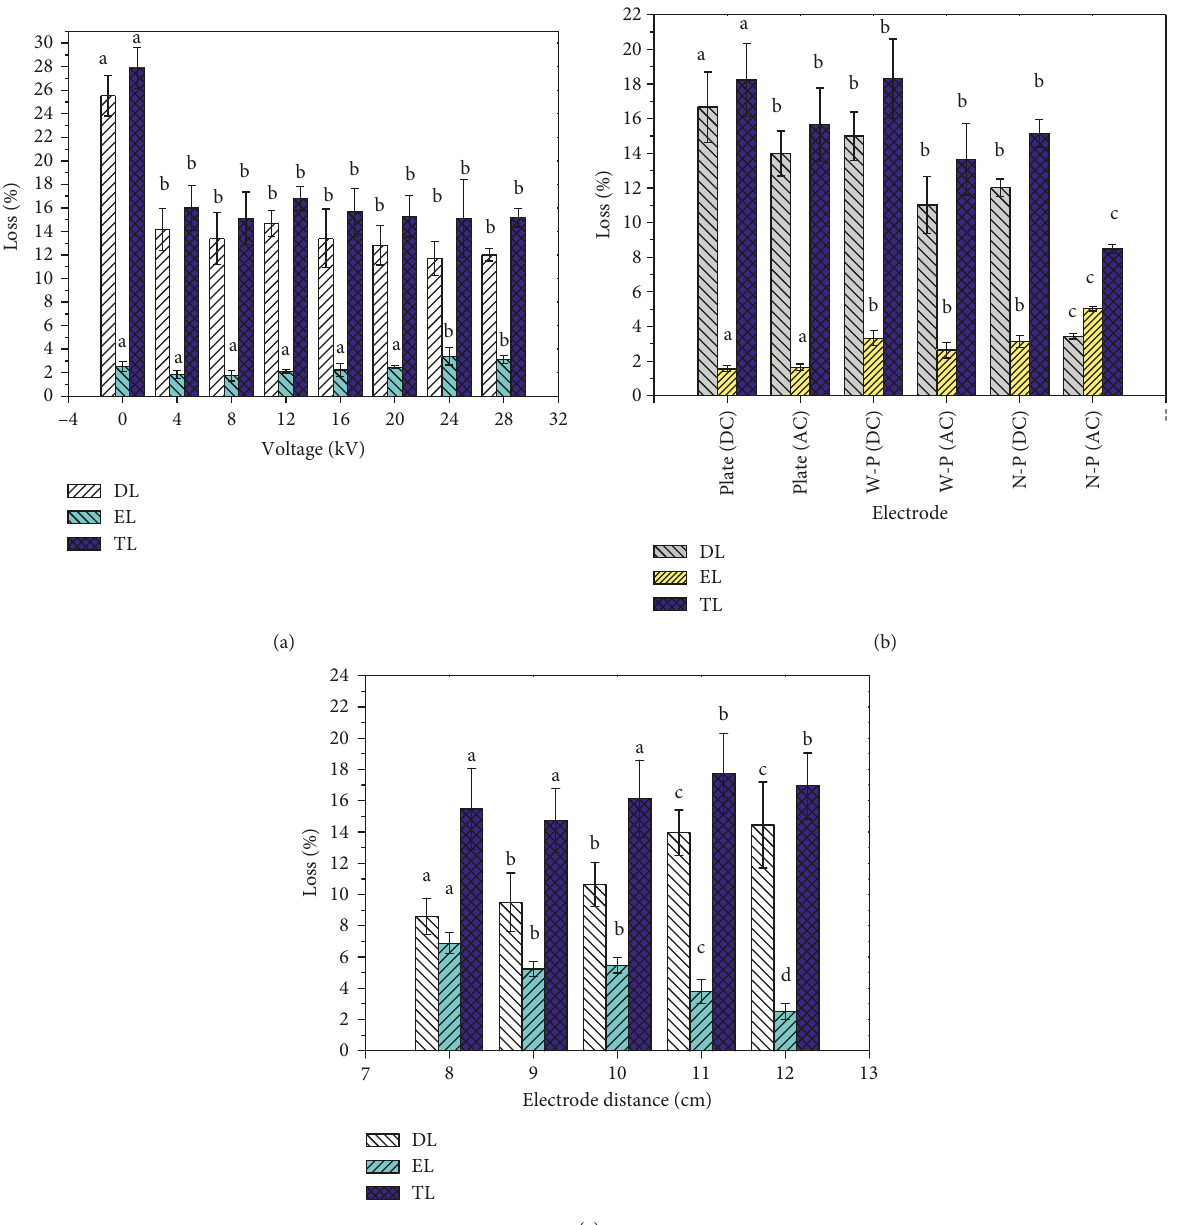
Figure 4: (a) The evaporation loss, thawing loss, and drip loss of tofu under different voltages. The frozen tofu was thawed at 20 ° C with a fixed discharge gap of 100mm under DC electric field. The thawing voltage was 0kV (the control samples), 4kV, 8 kV, 12kV, 16kV, 20kV, 24kV, or 28kV, respectively. For each treatment, means with different lower case letters are significantly different ( p evaporation loss, thawing loss, and drip loss of tofu under different electrodes. Plate (DC): the plate-to-plate electrodes under DC electric field, plate (AC): the plate-to-plate electrodes under AC electric field, W-P (DC): the wires-to-plate electrodes under DC electric field, W-P (AC): the wires-to-plate electrodes under AC electric field, N-P (DC): the needles-to-plate electrodes under DC electric field, and N-P (AC): the needles-to-plate electrodes under AC electric field. The corresponding discharge gap between the high-voltage electrodes and the grounded electrode was 100mm. The corresponding voltage was 28kV. For each treatment, means with different lower case letters are significantly different ( p 0 . 05). (c) The evaporation loss, thawing loss, and drip loss of tofu under different electrode distances. The discharge gap was 8 cm, 9cm, 10cm, 11cm, and 12cm with multiple needles-to-plate electrode for AC electric field, respectively. The corresponding voltage was 20kV. For each treatment, means with different lower case letters are significantly different ( p <